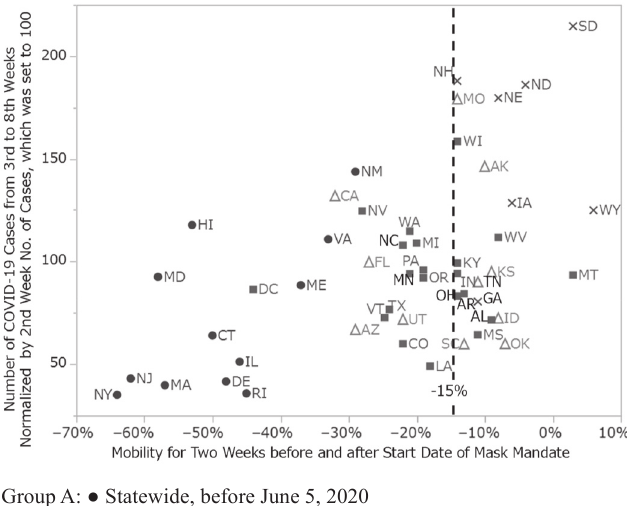
Figure 4. Number of COVID-19 cases from 3rd to 8th weeks versus mobility